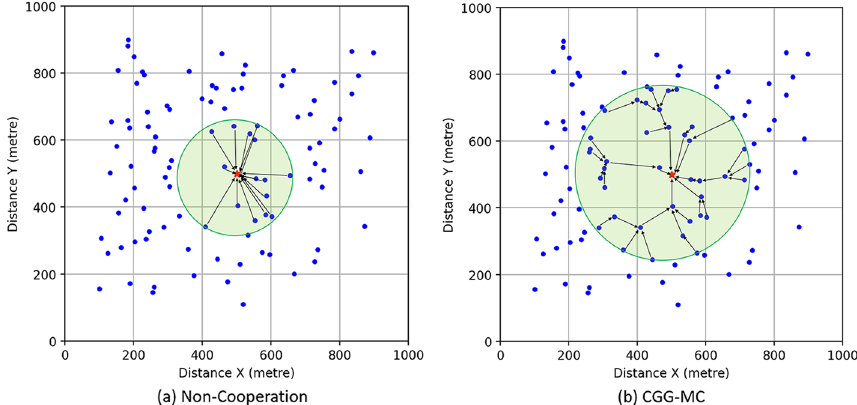
Fig. 9 Coverage area of non-cooperation model versus CGG-MC